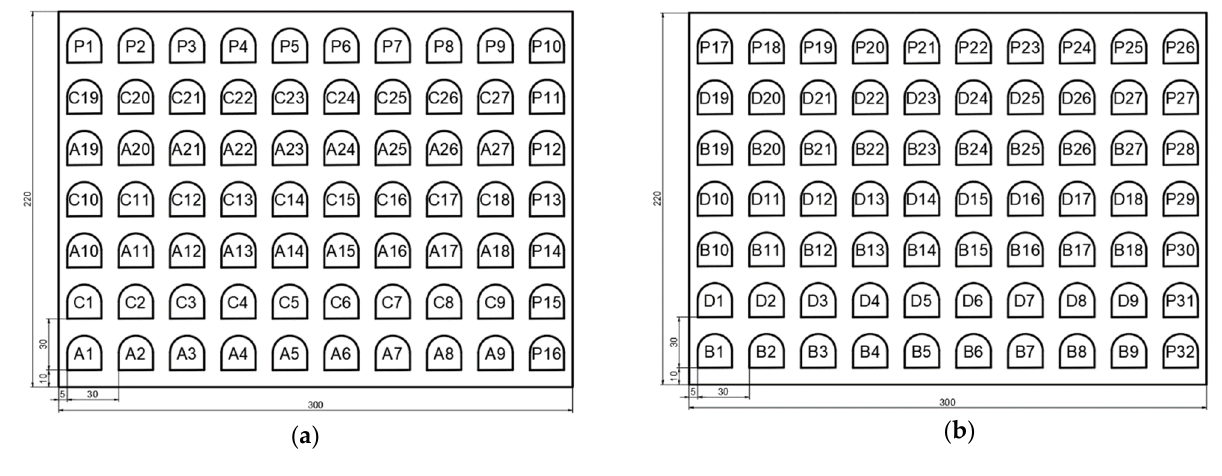
Figure 1. Cutting plan. ( a ) Part 1–70; ( b ) Part